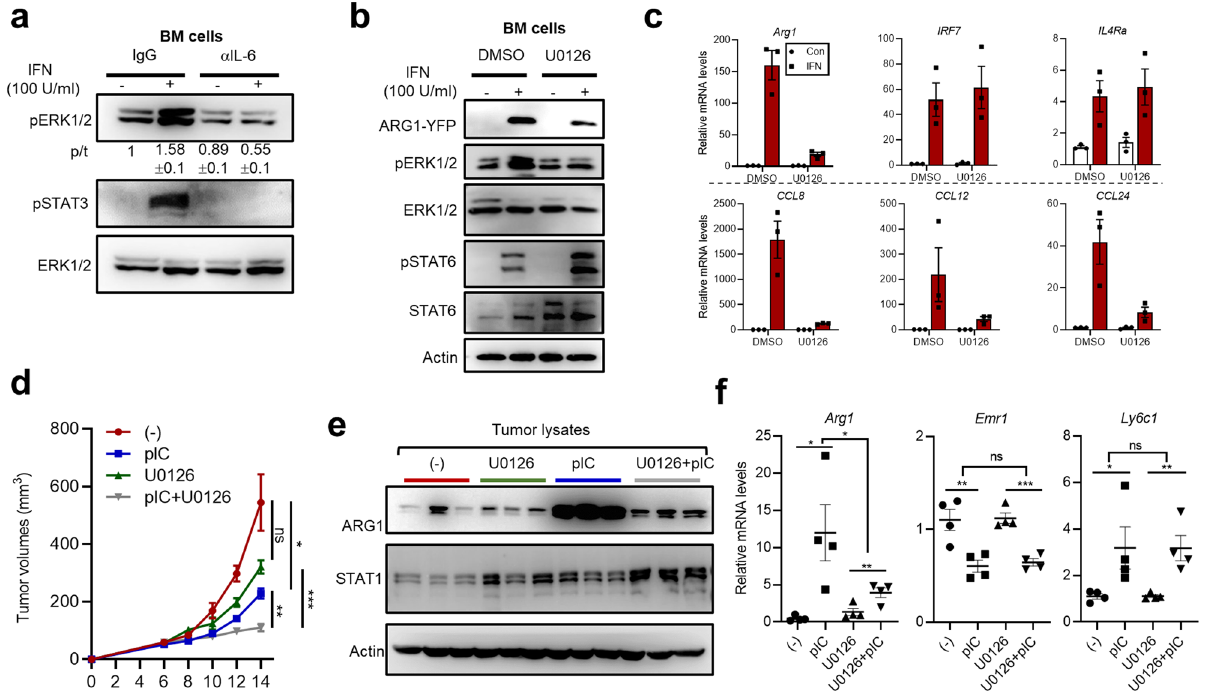
Figure 5. IL-6-ERK signaling is involved in promoting M2-skewed phenotype of IFN-stimulated transitional monocytes, and potentially in contributing to pro-tumoral polarization of TAMs under poly(I:C) treatment. ( a ) BM mononuclear cells were treated with M-SCF (20 ng/ml) ± IFN (100 U/ml) for 24 h, in the presence or absence of IL-6 neutralizing antibody (5 μg/ml). The cells were harvested and subjected to WB analyses. ( b,c ) BM mononuclear cells were treated with M-SCF (20 ng/ml) ± IFN (100 U/ml) for 48 h, in the presence or absence of U0126 (2.5 μM). The cells were harvested and subjected to WB analyses ( b ) or qPCR (n = 3, ± SEM) ( c ). ( d–f ) The mice were injected with 1 × 10 6 LLC cells in the flanks. Tumor-bearing mice were treated ± poly(I:C) ± U0126 (20 μmol/kg) (i.p.) every 2 days. Tumors were harvested after 4 treatments. In ( d ), the time-dependent changes in tumor sizes are presented (± SEM, n = 4). Multiple unpaired t tests (using Holm– Šídák method) were performed to compare measurements from different groups. The adjusted P values for the end-point data were shown on the graph. At the end of the animal experiment, the tumors were harvested. Results from WB ( e ) or qPCR analyses [n = 4, ± SEM] ( f ) are presented. Unpaired t tests were performed for individual markers. Asterisks in this figure correspond to P values (*** P < 0.001; ** P < 0.01; * P < 0.05; ns not